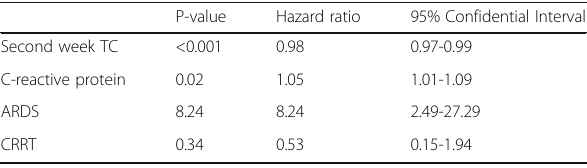
Table 79 (abstract A249). Risk factors for hospital